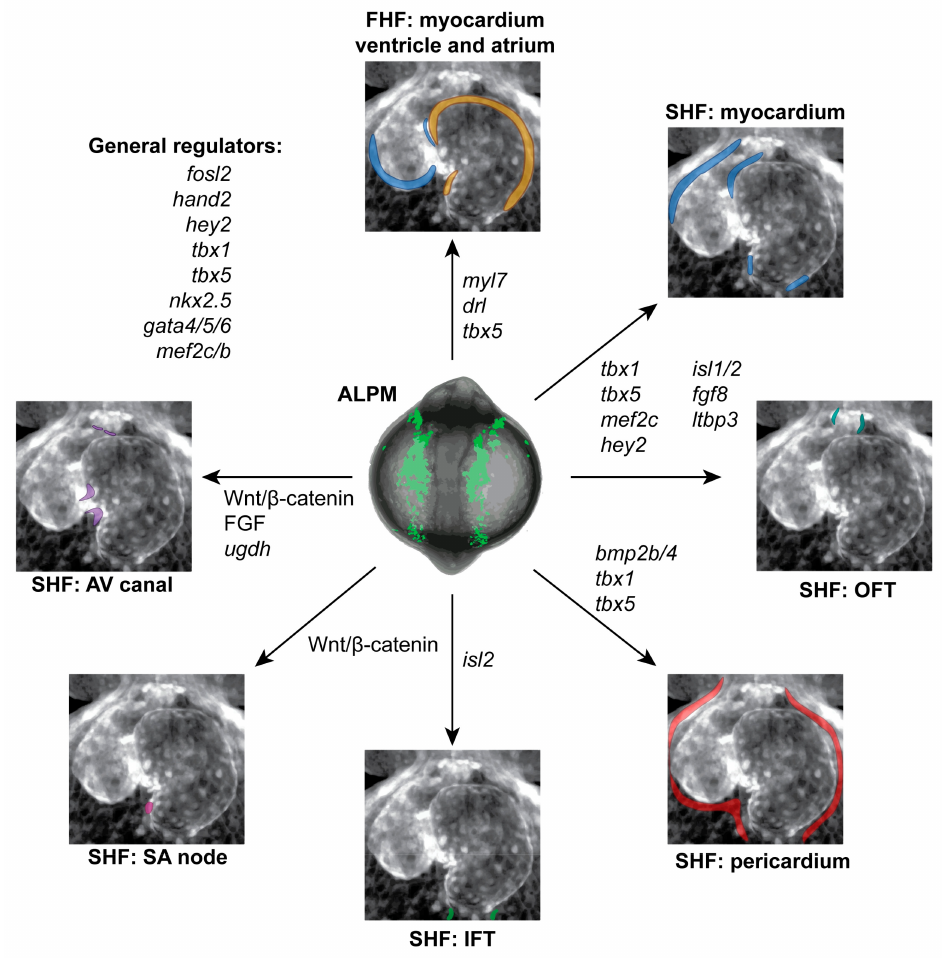
Figure 2. Genes contributing to early heart development in zebrafish. Overview of select genes and pathways involved in the formation and patterning of individual structures of the zebrafish heart, as representative at 3 dpf. Individual parts of the heart are color-coded corresponding to Figure 1. See text for